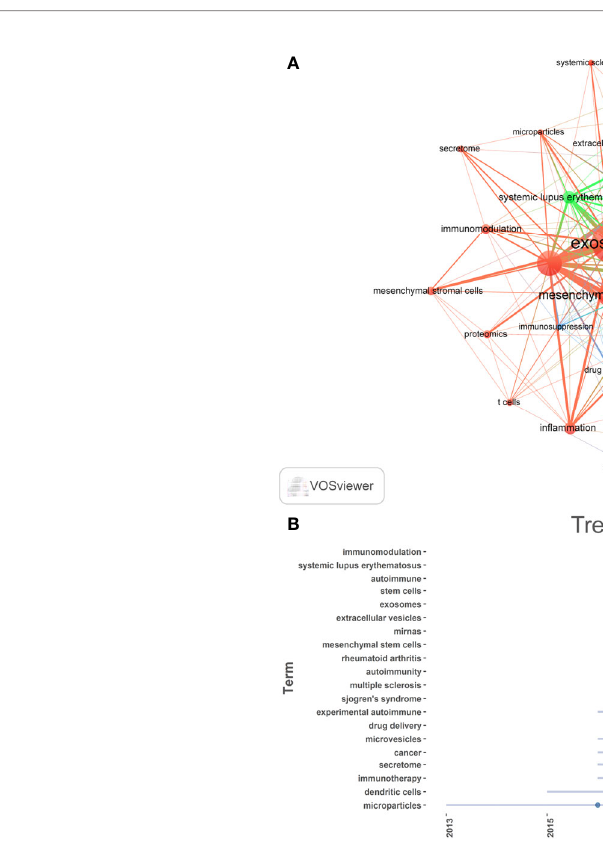
FIGURE 10 | Keyword cluster analysis (A) and trend topic analysis (B) .